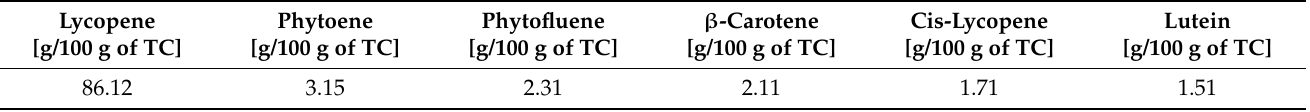
Table 2. Carotenoids composition in tomato peels [29].